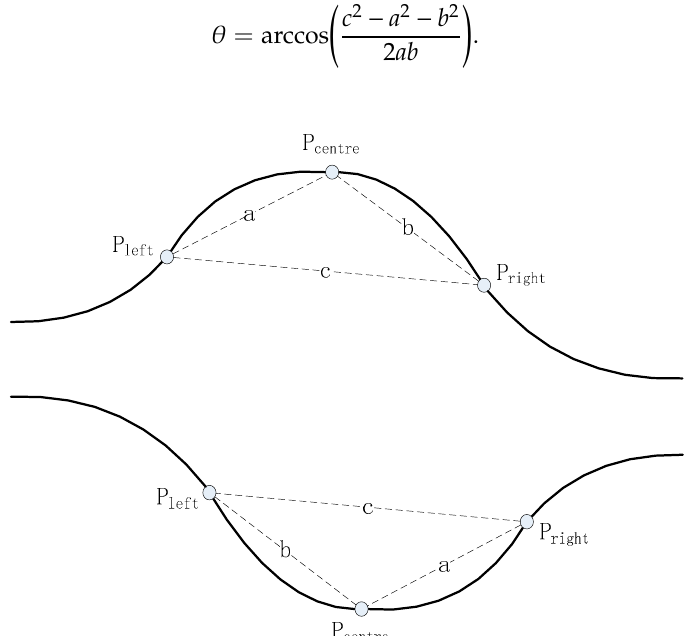
Figure 9. Peaks and valleys have the same calculation results. P centre is the selected point, V left and V right are adjacent points of the selected point, and a, b, and c are lengths of three sides of a triangle. Note that the angles of the triangle are related to the length of three sides.